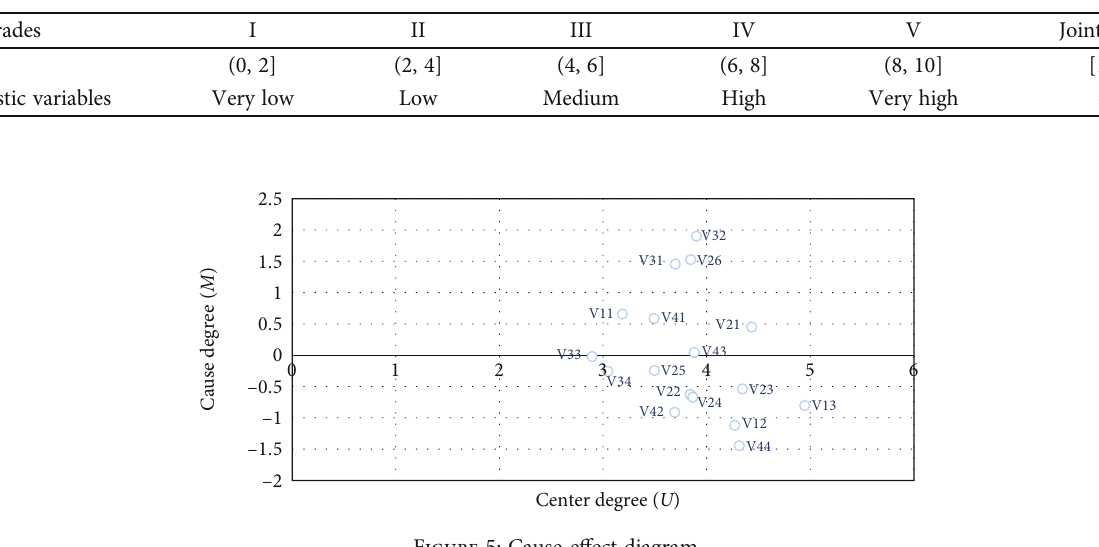
Figure 5: Cause-e ff ect